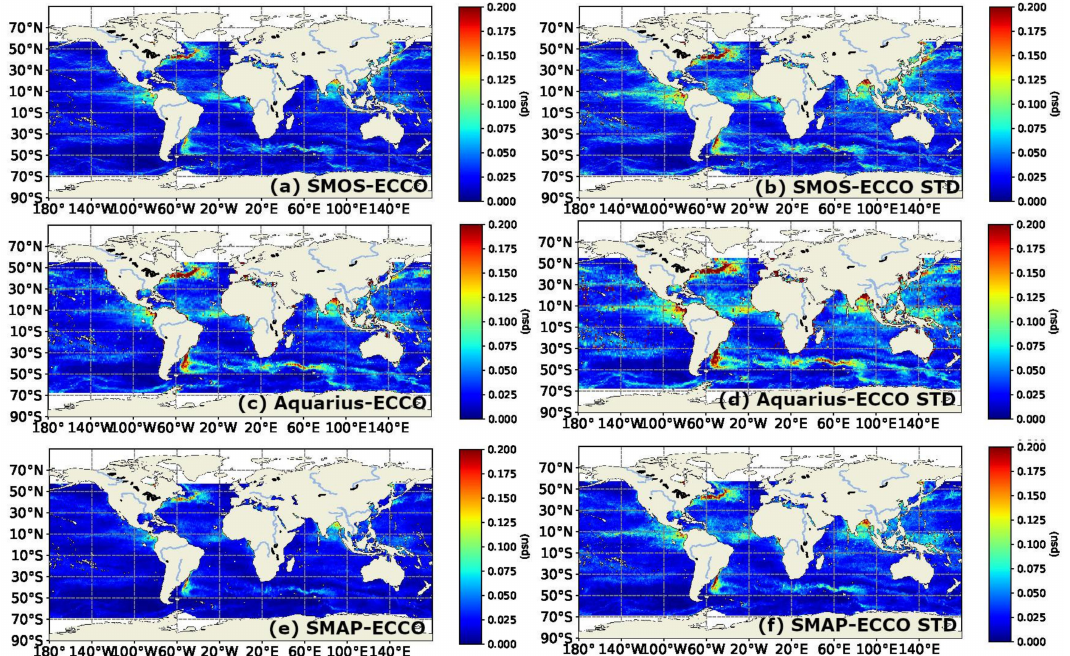
Figure 3. Maps of the absolute mean ( left column ) and standard deviation ( right column ) of differ- ences between weekly ( a , b ) SMOS (9 days), ( c , d ) Aquarius (7 days), and ( e , f ) SMAP (8 days) and ECCO SSS over the 1-year model